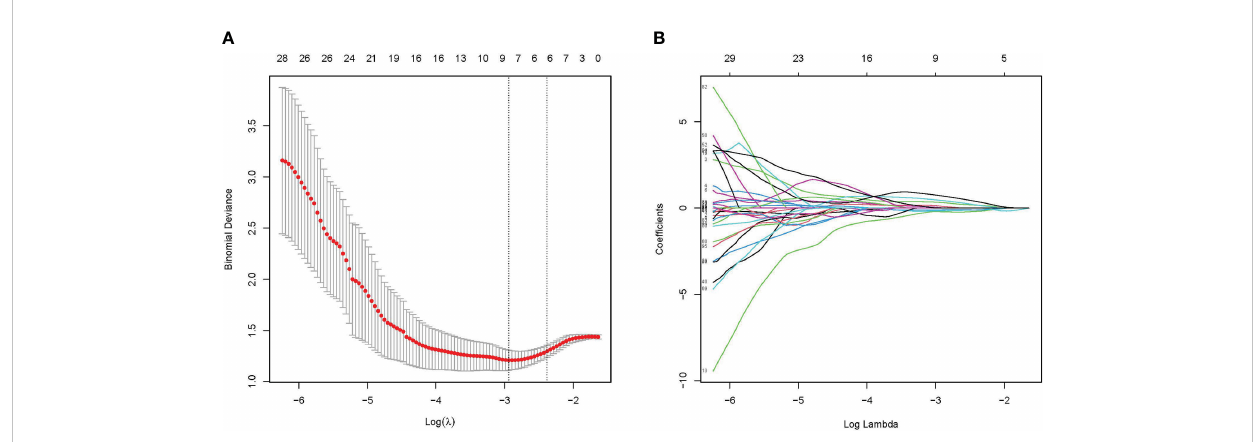
FIGURE 2 Radiomics feature selected by LASSO regression algorithm. (A) Plotting of multinomial deviance versus log( l ). (B) LASSO coef fi cient pro fi les of the radiomics